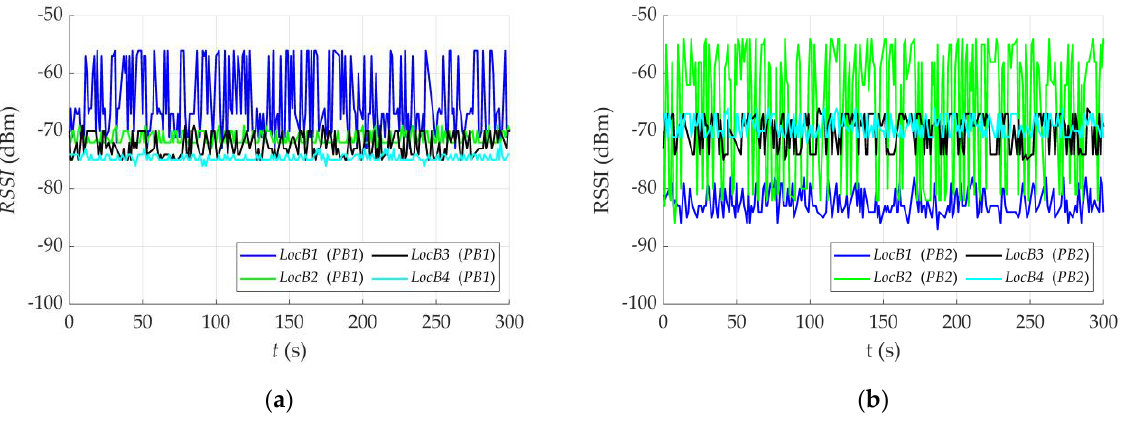
Figure 11. Measurements of RSSI values obtained by four locator nodes for an object placed 1.8 m from the receiver: ( a ) LocB1 (location PB01 ); ( b ) LocB2 (location PB02 ).